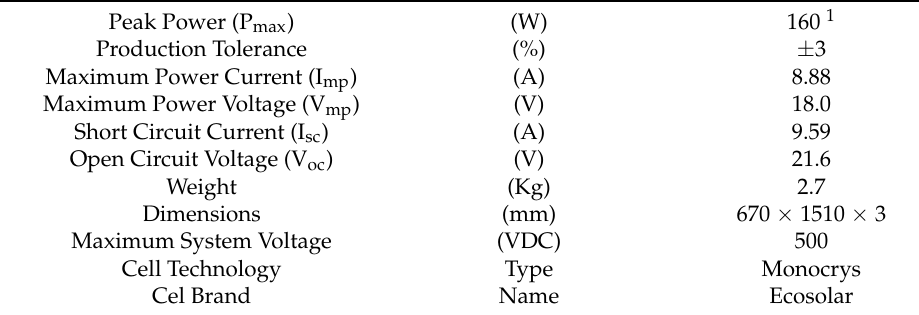
Table 2. PV Modules technical characteristics.